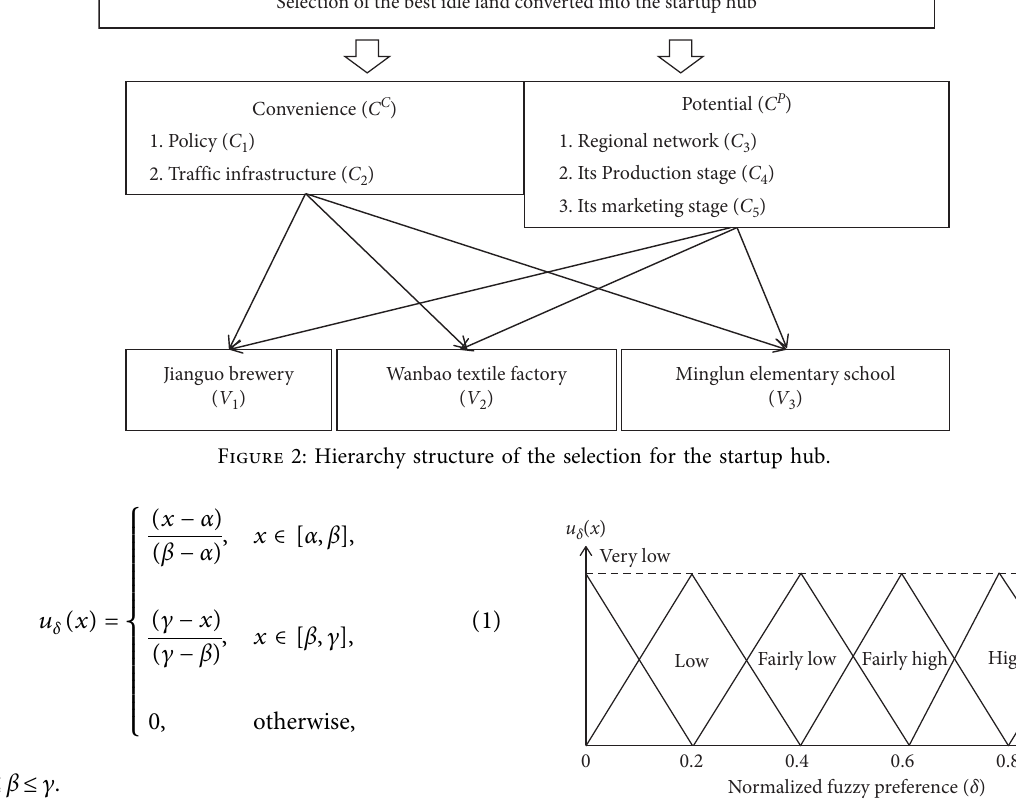
Figure 3: The linguistic variables of fuzzy ratings for the alter- native’s